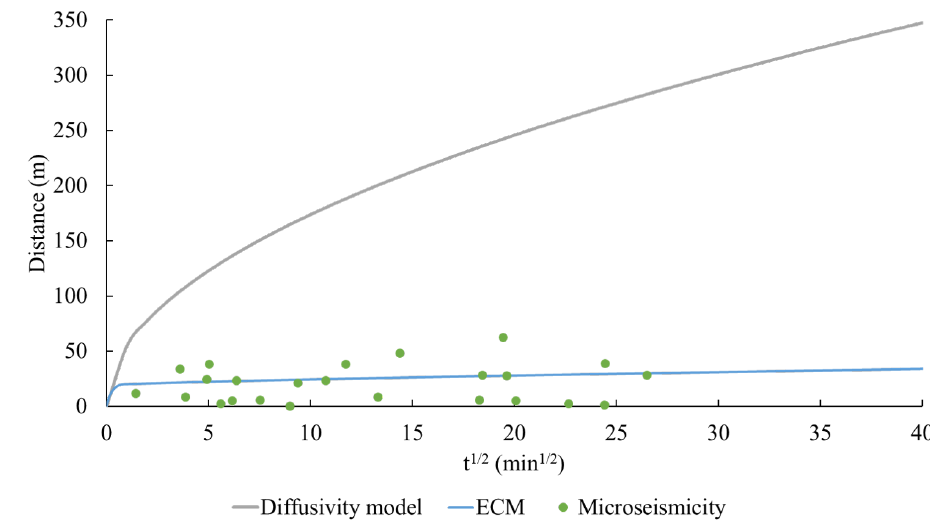
Figure 10. Comparison of fracture length increment along minimum in-situ stress direction using diffusivity and ECM models. The green dots indicate recorded microseismicity along minimum in-situ stress